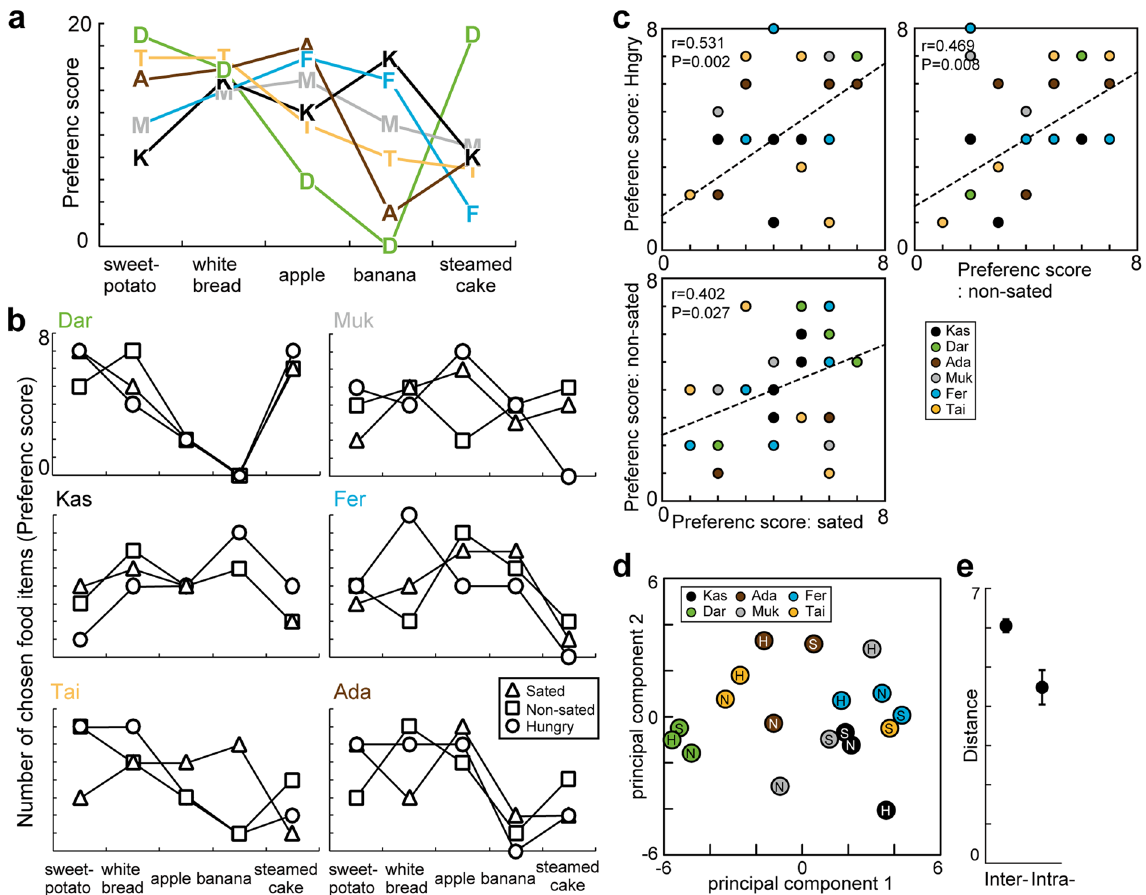
Figure 2. Individual food preferences inferred from the animals’ choices. ( a ) The preference score, defined as the number of chosen food items, was plotted for the six monkeys. Aggregated data of three food access conditions were plotted for each monkey. The possible score ranged from zero to 24 for 60 choices. Characters in the figure indicate individual monkeys (A:Ada, D:Dar, F:Fer, K:Kas, M:Muk, and T:Tai). ( b ) Same as a , but for the preference score in each of three food access conditions in the six monkeys. The possible score ranged from zero to eight for 20 choices in each of the three food access conditions. ( c ) Pairwise plots of the preference scores in the three food access conditions. Dashed lines indicate regression slopes. Correlation coefficients and statistical significance are shown. ( d ) Comparison of the preference scores between and within monkeys. The preference scores in each condition in each animal were plotted in Euclidean space using principal component analysis. S: sated condition, N: non-sated condition, H: hungry condition. ( e ) Plot of the averaged interindividual and intraindividual distances. Error bars indicate the